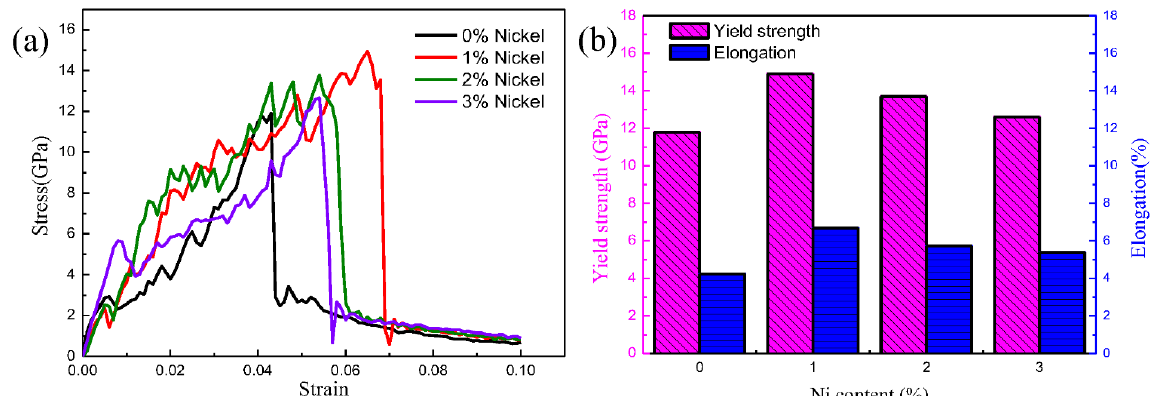
Figure 11. Tensile mechanical properties of Fe/Cu bimetal with different Ni contents: ( a ) tensile stress – strain curve; ( b ) dependence of yield strength and elongation on Ni content. stress–strain curve; ( b ) dependence of yield strength and elongation on Ni